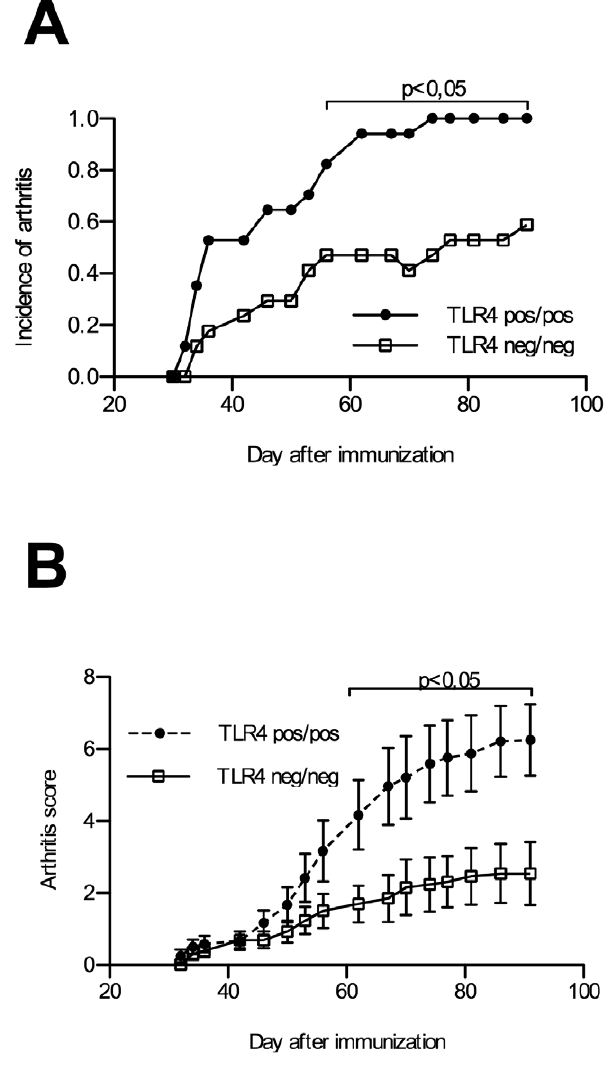
Figure 1. Incidence and severity of arthritis. Suppressed incidence (A) and severity (B) of collagen induced arthritis (incomplete Freund’s adjuvant) in TLR4 defective DBA/1J (n=17) compared to TLR4 pos/pos (n=17) DBA1/J mice.